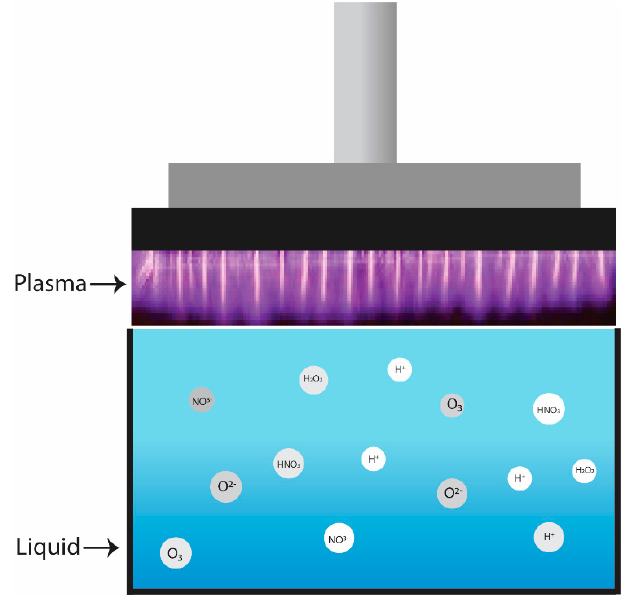
Figure 1. Plasma-activated water generation.